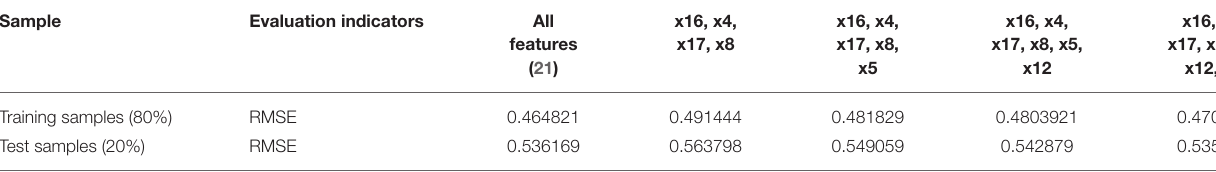
TABLE 6 | Random forest’s five-fold crossover experiment results.